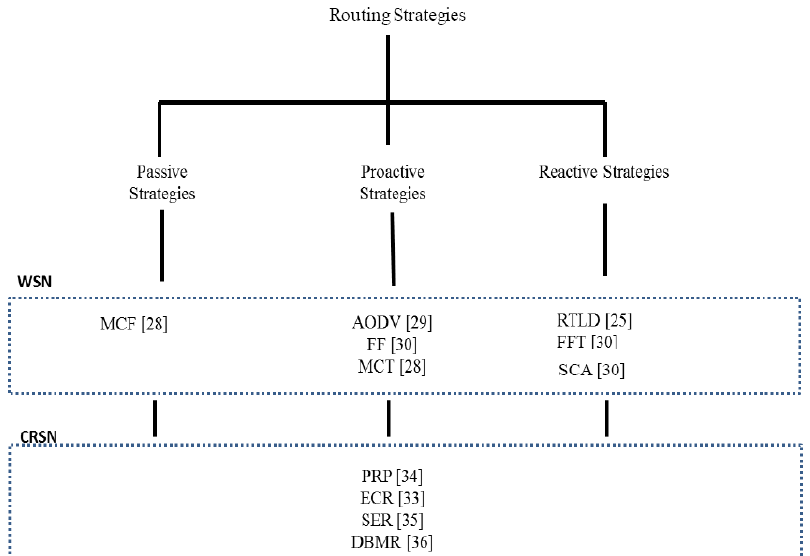
Figure 2. Classification of routing protocols with respect to transmission